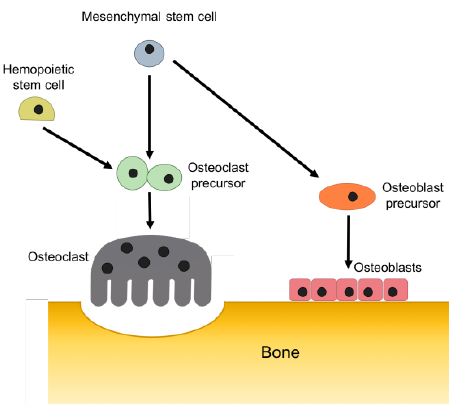
Figure 2. Evolution of osteoblasts and osteoclasts of bone.